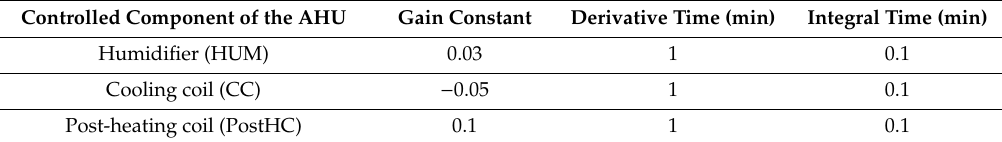
Table 8. Main parameters of PID